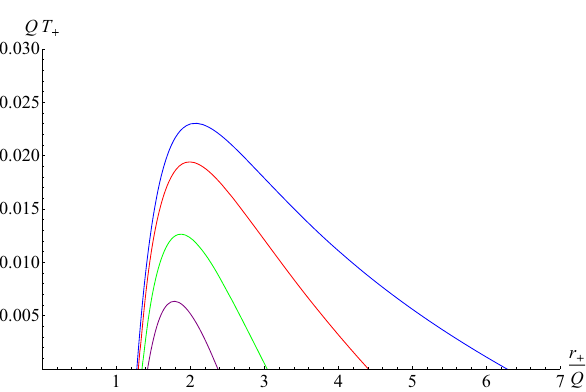
different values of the reduced pressure PQ 2 . The blue, red, green and